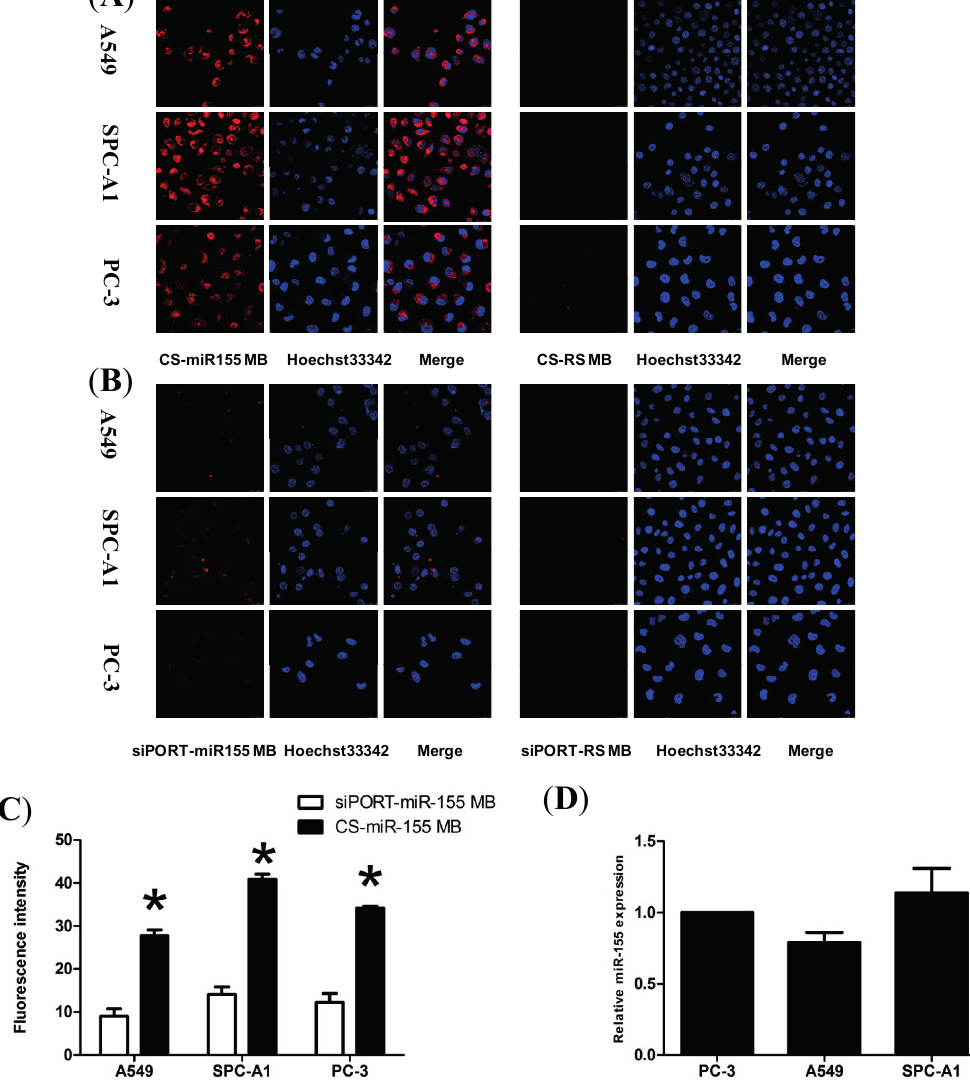
Figure 3. Fluorescence imaging and detecting in viable cells. ( A , B ) Confocal microscopy imaging of the three cells transfected with CS-miR155 MB and CS-RS MB complexes or transfected by the commercial siPORT transfection agent. RS MB was used as a negative control. All cell nucleuses were stained by Hoechst33342 (blue). Scale bar = 25 μ m. ( C ) Fluorescence intensity of Cy5 was measured after incubation with CS-miR155 MB or siPORT-miR155 MB. * p < 0.05. ( D ) T he relative miR-155 expression levels were analyzed in A549, SPC-A1 and PC-3 cells using